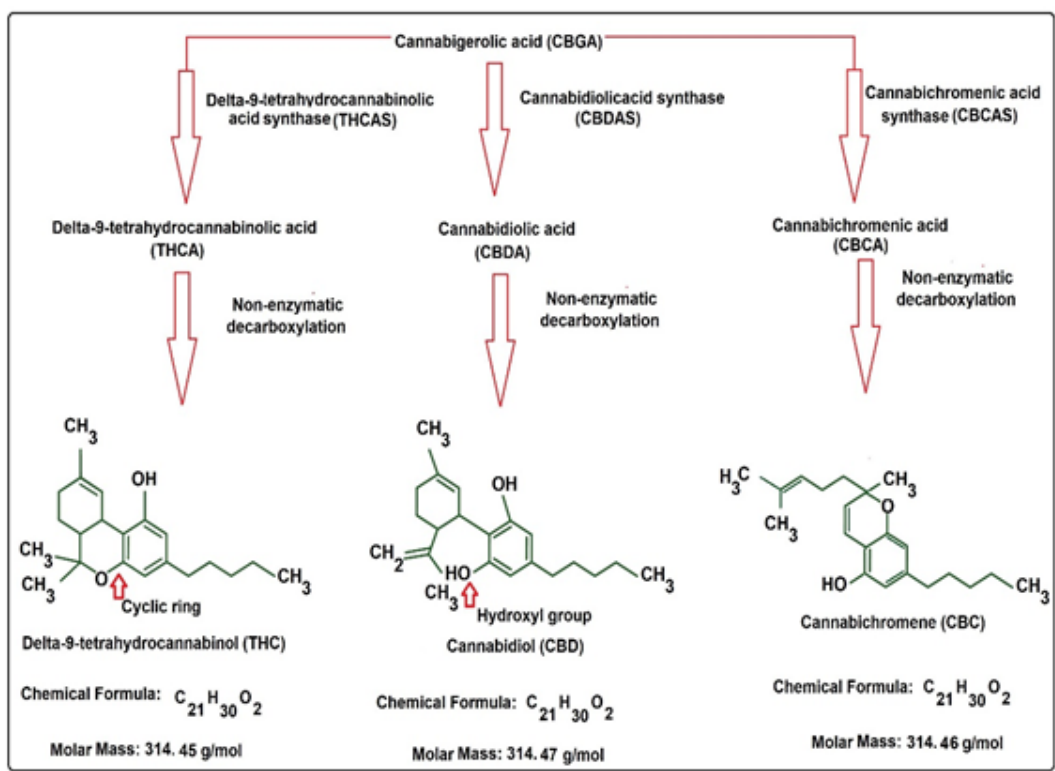
Figure 3. Summary of biosynthesis pathways of primary